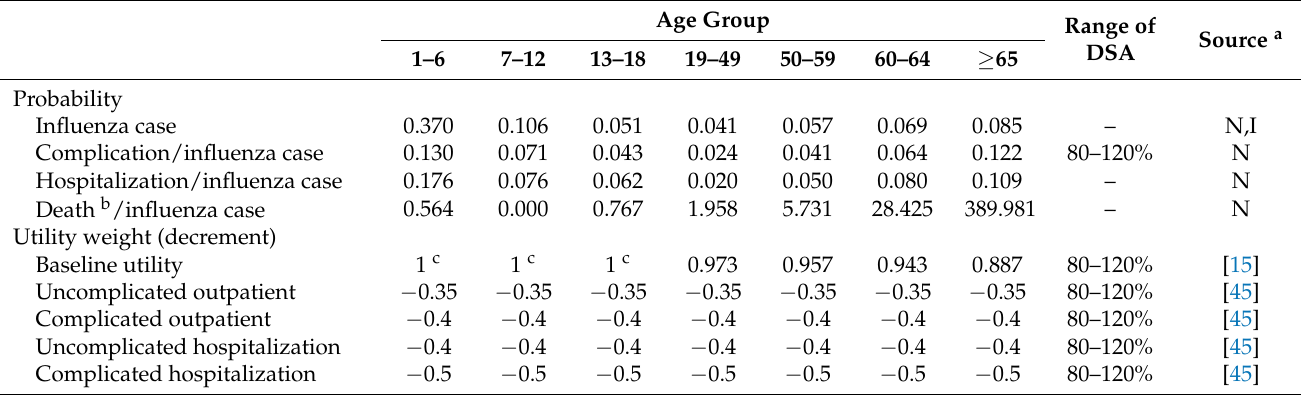
Table 2. Probabilities and